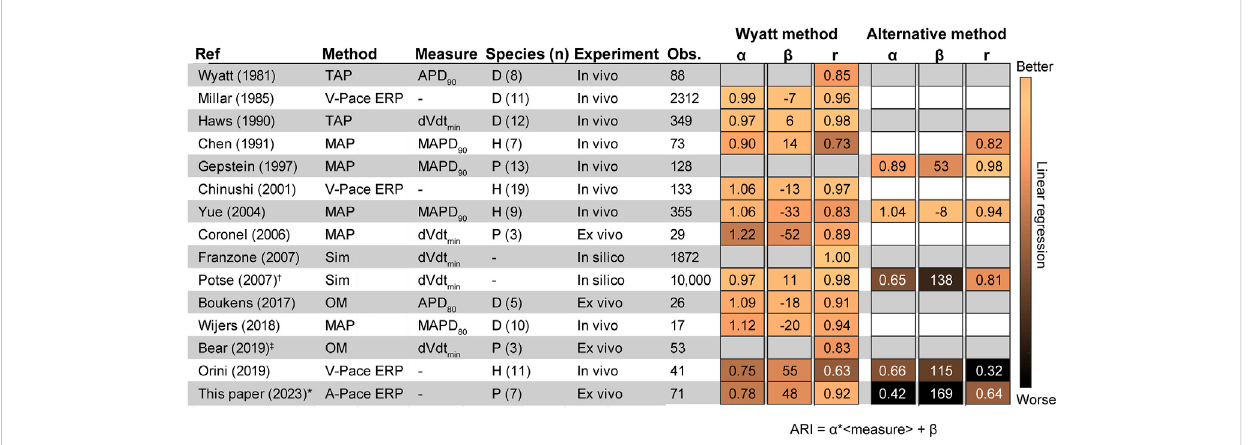
FIGURE 6 Literature results comparing the invasive unipolar electrogram (UEG) T-wave to different outcome measures. (Wyatt et al., 1981; Millar et al., 1985; Hawsand Lux,1990;Chenetal.,1991;Gepstein etal.,1997;Chinushietal., 2001;Yue etal.,2004;Coroneletal.,2006;Franzone etal.,2007;Potse etal., 2007;Boukensetal.,2017;Wijersetal.,2018;Bearetal.,2019a;Orinietal.,2019).TheFigureshowsPearson ’ sr,theslope( α )andintercept( β )accordingto the equation ARI = α · < local measure > + β , i.e., for Orini (2019): RT = α · V-pace ERP+ β (Figures 3, 4 for an example). † : Analysis only for positive T-waves. ‡ :RTinsteadofARI(Figure2A).Ifpooleddataonr, α and/or β werenotavailable,aweightedaveragewascalculatedforseparateexperiments.D: Dog. H: Human. MAP: monophasic action potential. Obs.: number of observations. OM: Optical mapping. P: Pig. Sim: Simulation. TMP: transmembrane action potential. V-pace ERP/A-pace ERP: ventricular/atrial-paced effective refractory period (see